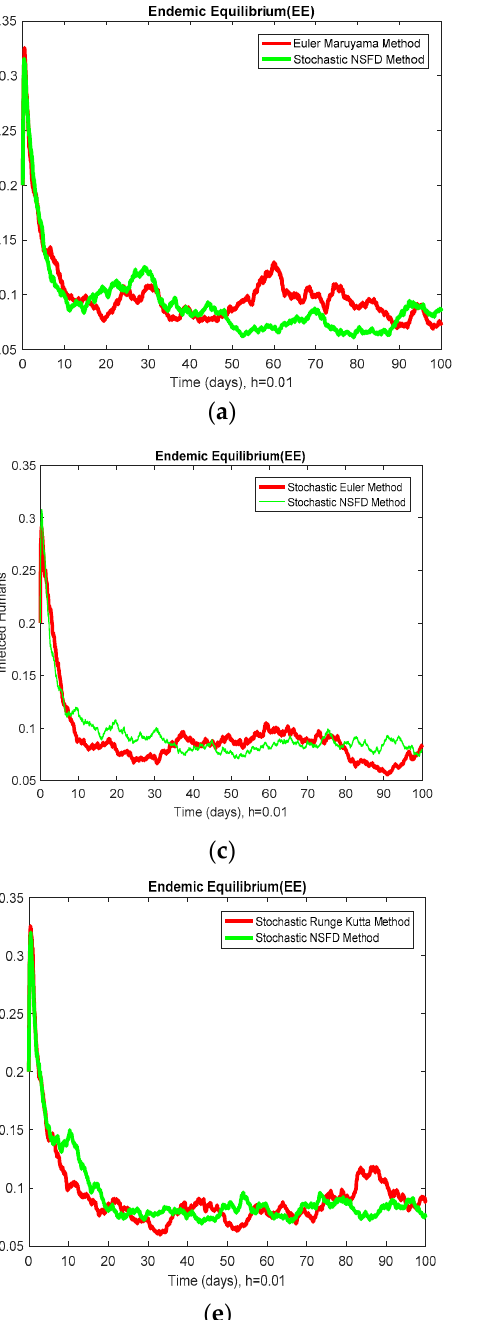
equilibrium at ℎ = 0.01 .